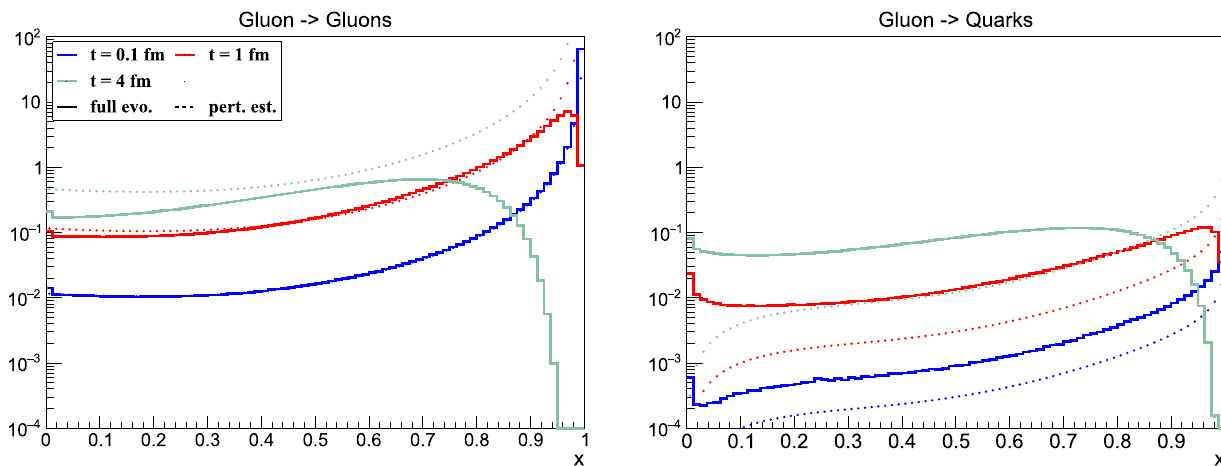
√ Fig. 12 The xD ( x , t ) distributions at the time-scales t = 0 . 1 , 1 , 4fm: cascades initiated by gluon. The solid lines correspond to the full medium evolution and the dotted line to the perturbative estimate